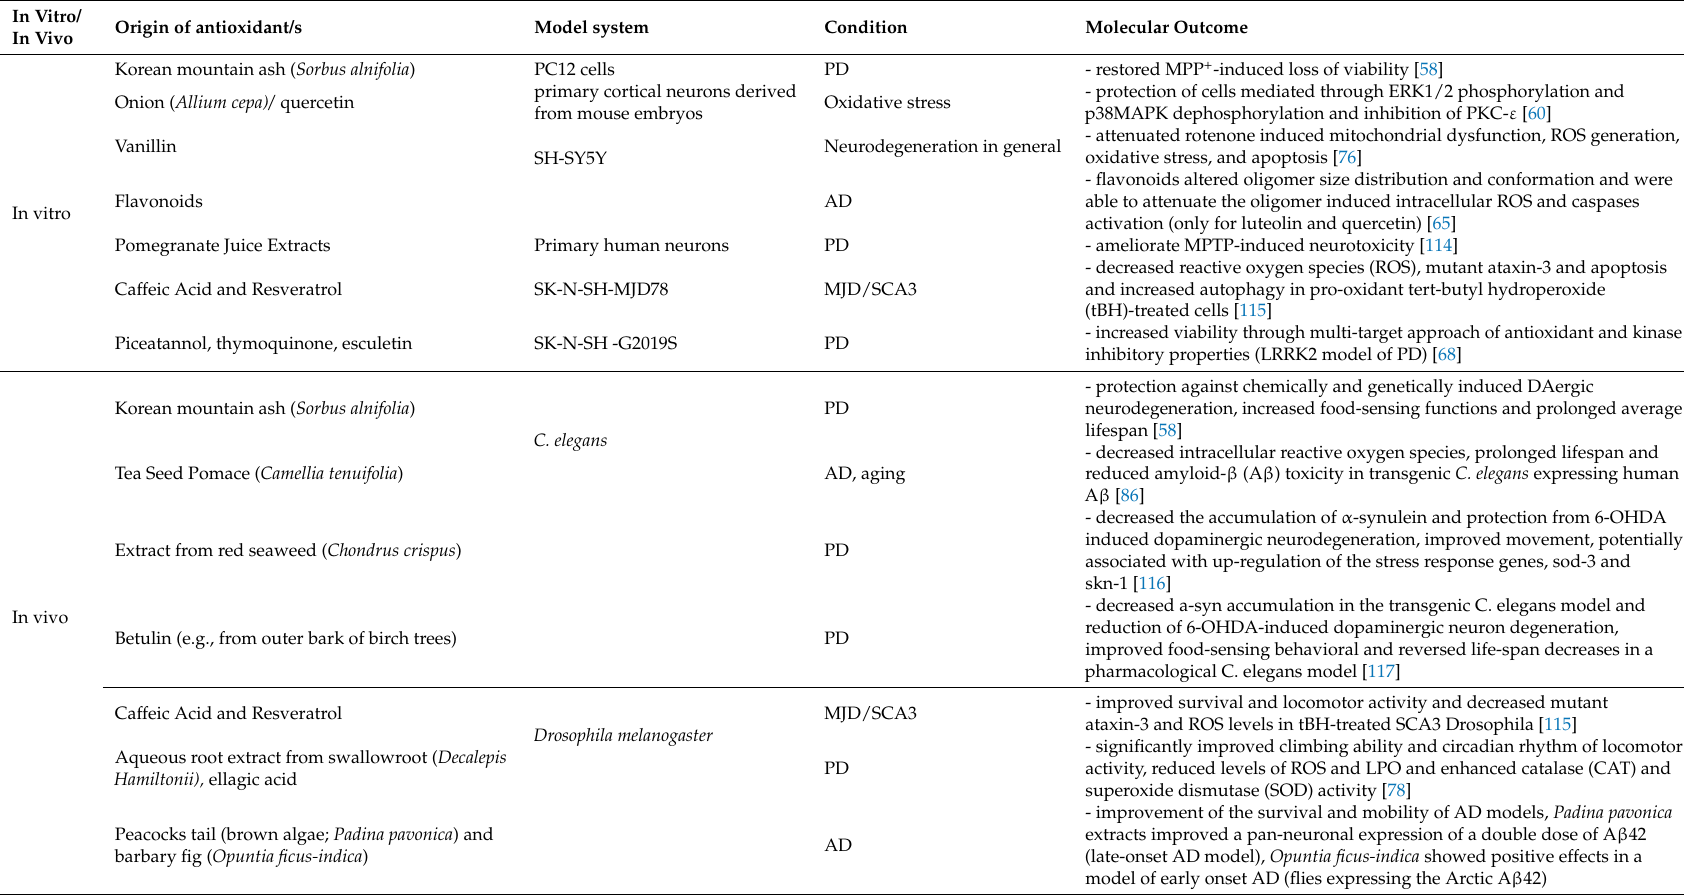
Table 2. Pre-clinical effect of natural antioxidants in vitro and in